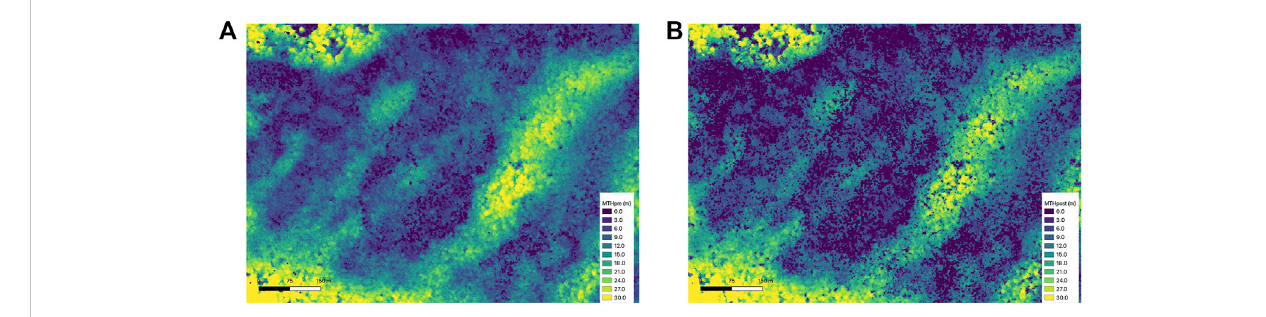
FIGURE 8 Pre- (A) and post- fi re (B) mean tree height near the Bull Head peak where Landsat and lidar based burn severity measures show inconsistent